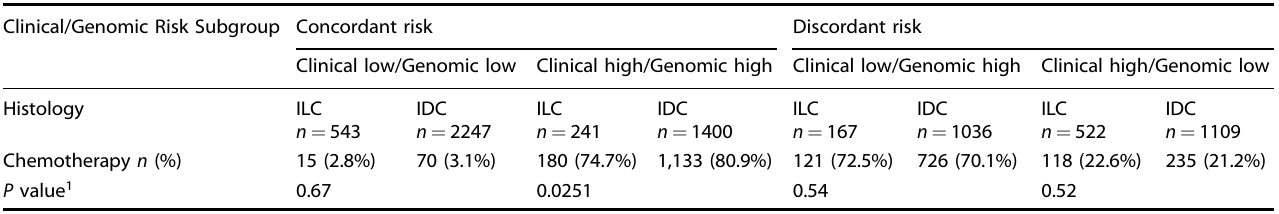
Table 3. Receipt of chemotherapy strati fi ed by clinical and genomic risk category and histologic subtype. Clinical/Genomic Risk Subgroup Concordant